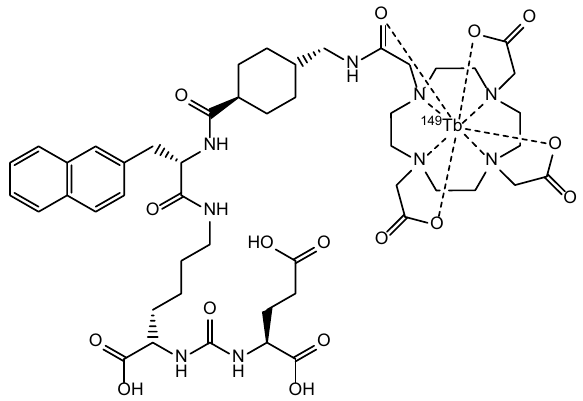
Fig. 3 Molecular structure of [ 149